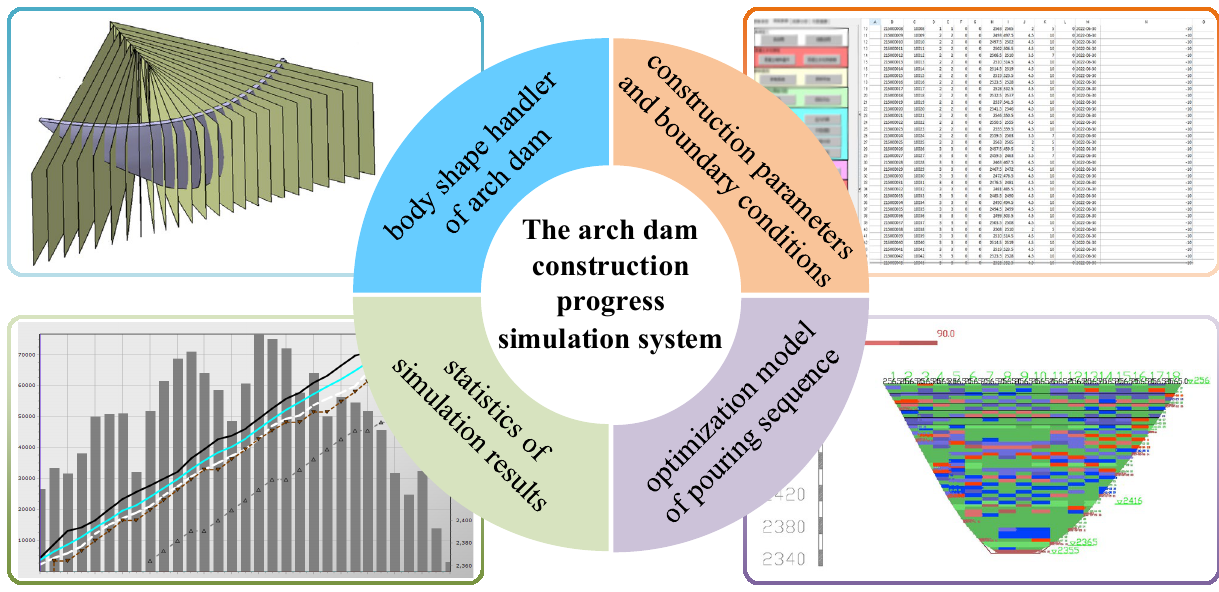
Figure 3. Framework of the arch dam construction progress simulation system.